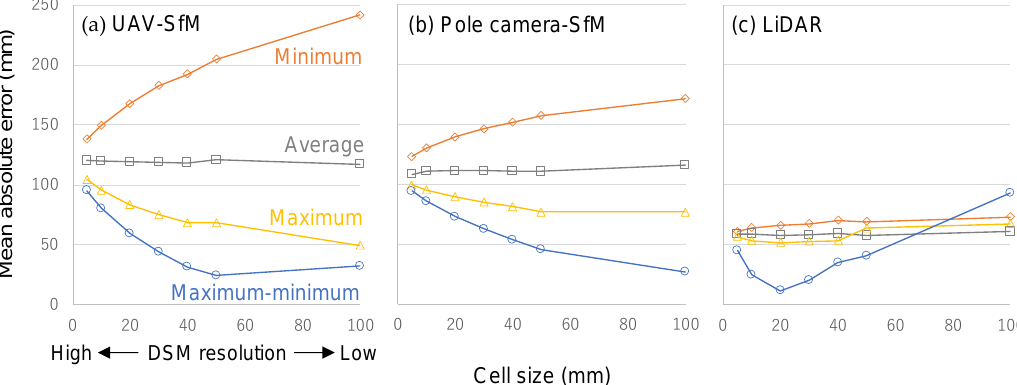
Figure 6. Effects of conversion method from point cloud data to height data of DSM cell, and DSM resolution on accuracy of plant height estimation: ( a ) shows the results of the UAV- structure from motion (SfM) method; ( b ) shows the results of the pole camera-SfM method; ( c ) shows the results of the LiDAR method.